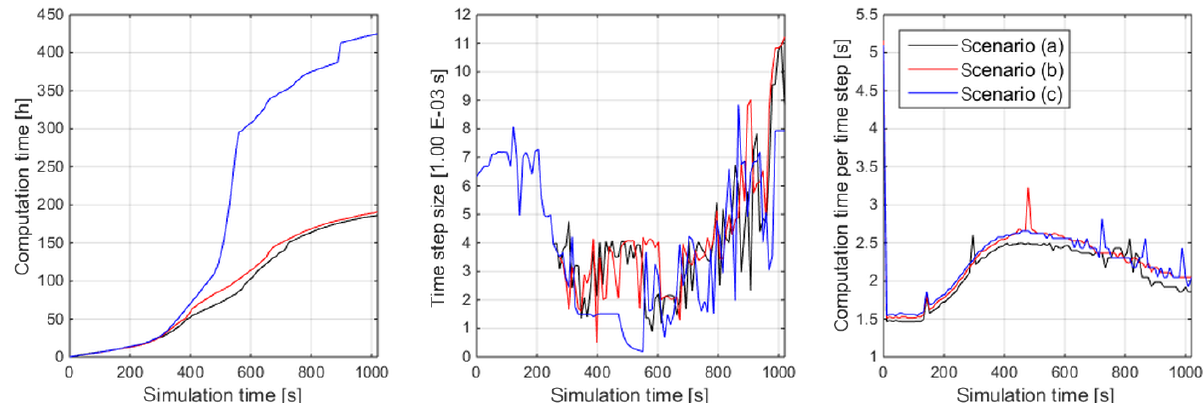
Figure 12. Computational effort – comparison of computation time (h) (left), time step size (1.0 E-3 s) (middle) and computation time per time step (s) (right) for the scenarios (a), (b) and